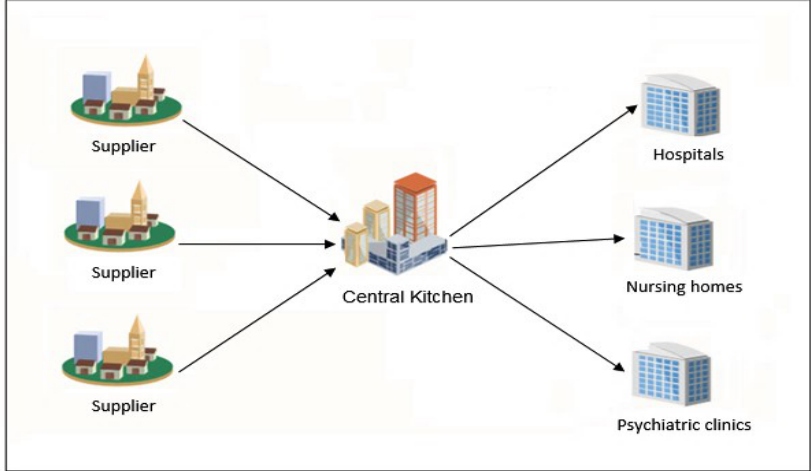
Figure 10. Logistics network of the hospital center of